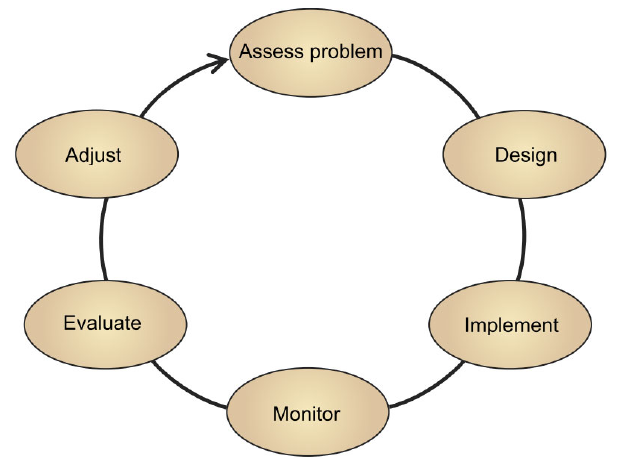
Fig. 1 . Diagram of the adaptive management process. Image reproduced from Adaptive management: the U.S. Department of the Interior technical guide (Williams et al.